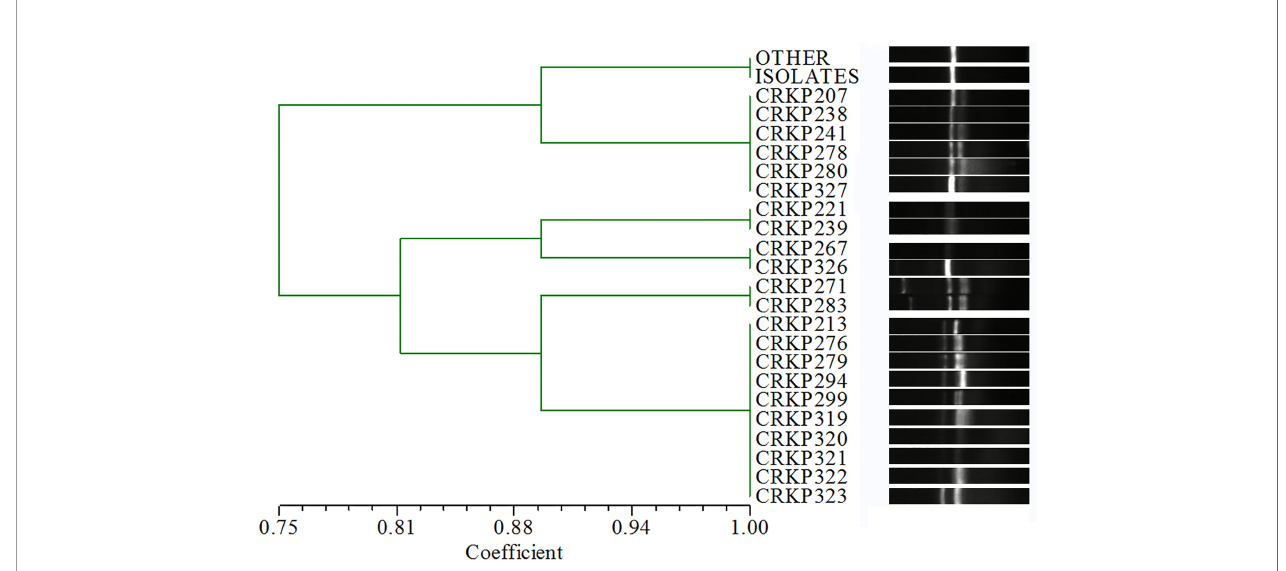
FIGURE 2 | ERIC-PCR results. The isolates with > 90%similarity coef fi cient for the cluster dendrogram and no signi fi cant band difference were determined to have the same genotype. “ OTHER ISOLATES ” refers to 105 isolates in addition to the 22 isolates listed in the fi